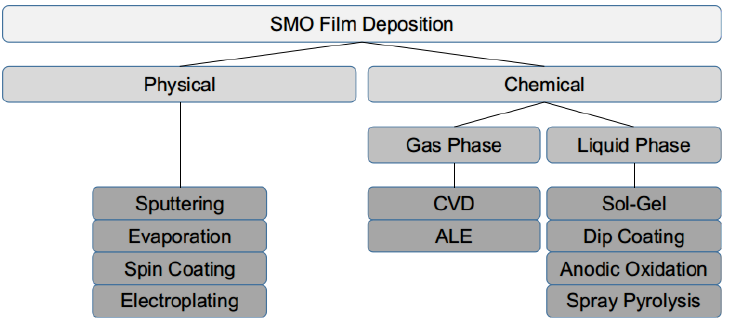
Figure 1. Summary of techniques used for SMO film deposition, where CVD is chemical vapor deposition and ALE is atomic layer